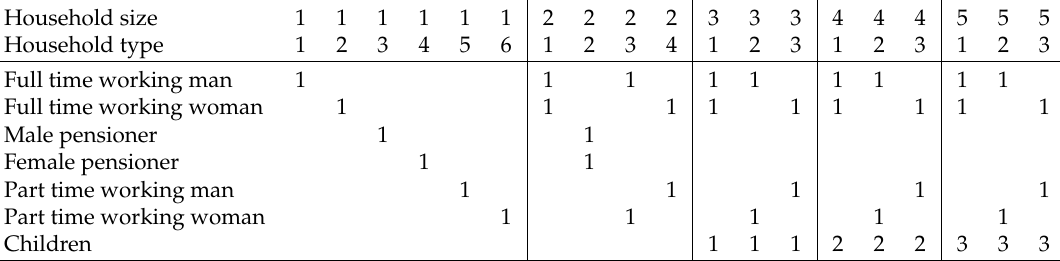
Table 1. Allocation logic of household parameters to